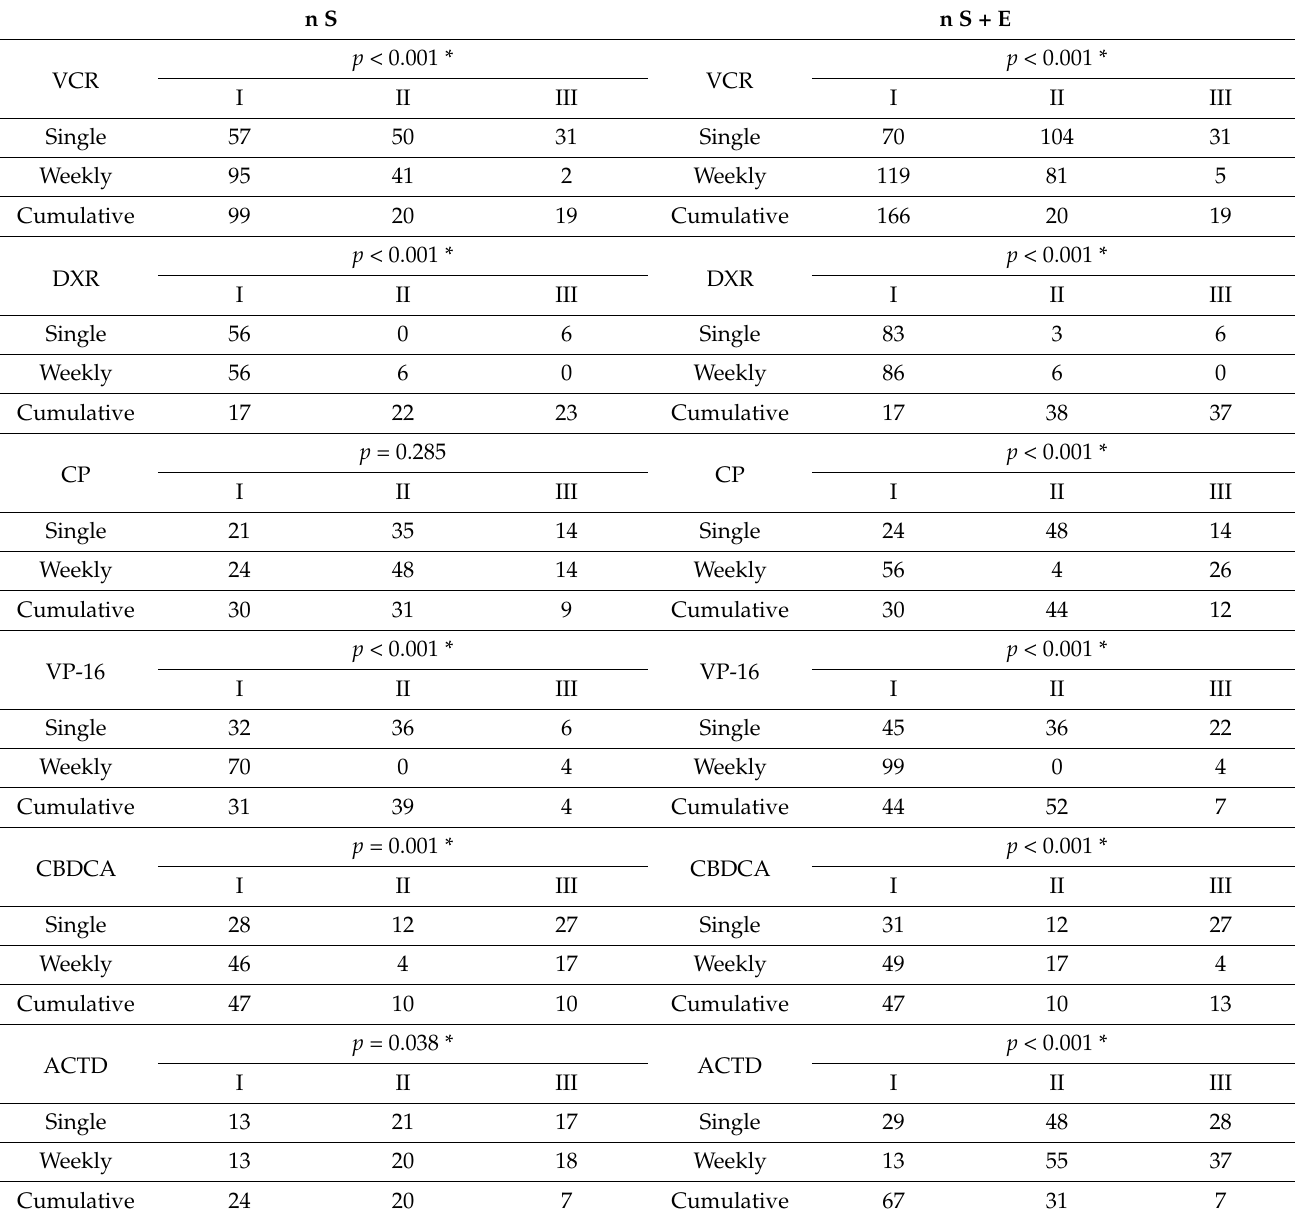
Table 5. Number of reported abnormalities depending on dose range and dose calculation approach— chi-square test results for single dose vs. weekly dose vs. cumulative